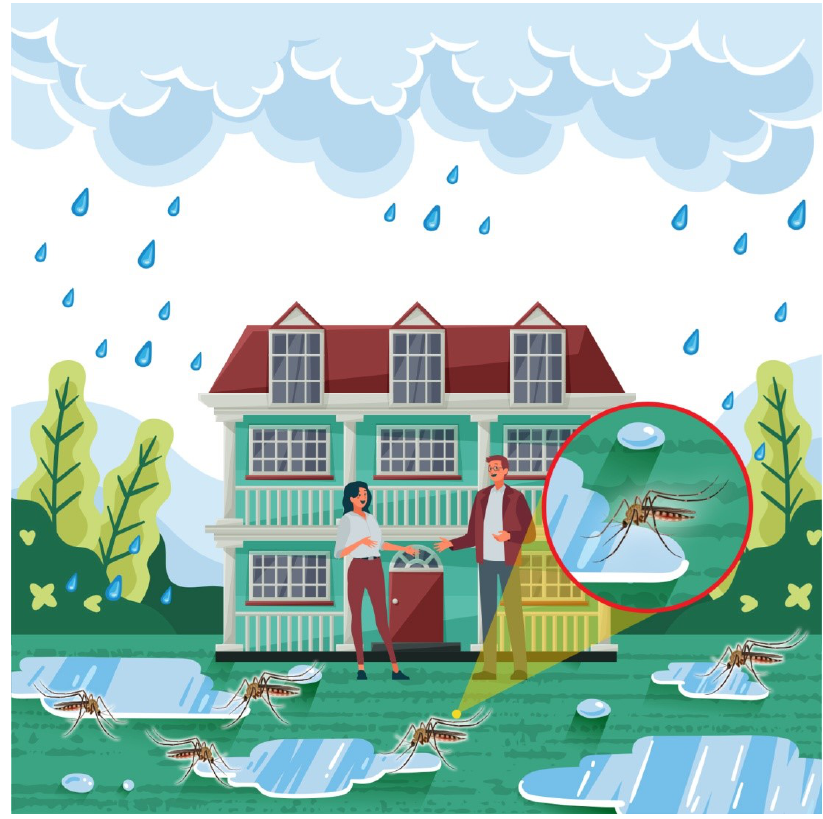
Figure 1. Dengue virus spreading